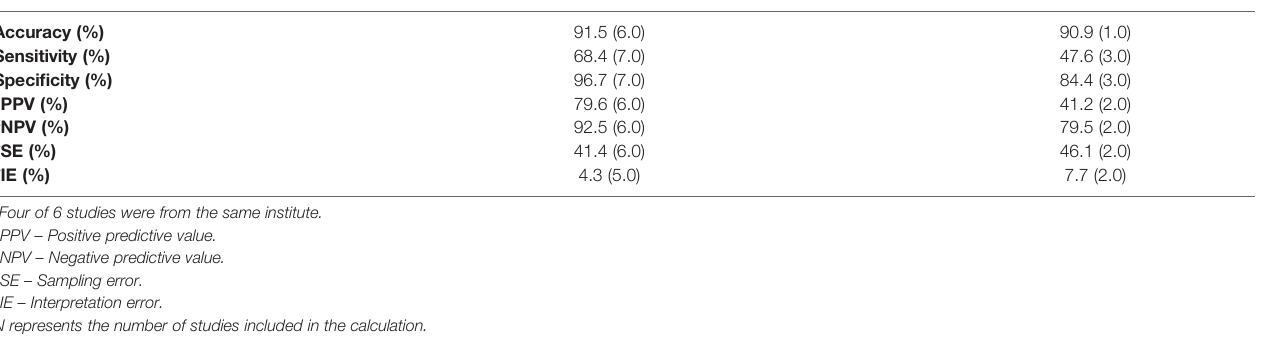
TABLE 3 | The non-weighted average IOARM performance parameters for soft tissue: specimen-driven vs defect-driven method. Performance parameters